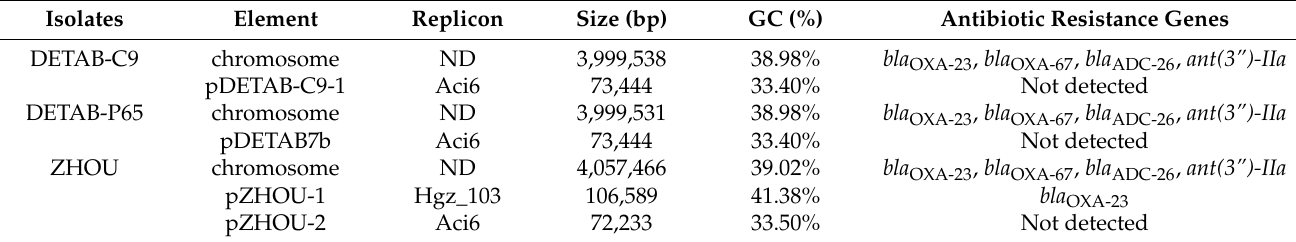
Table 2. Characteristics of genome